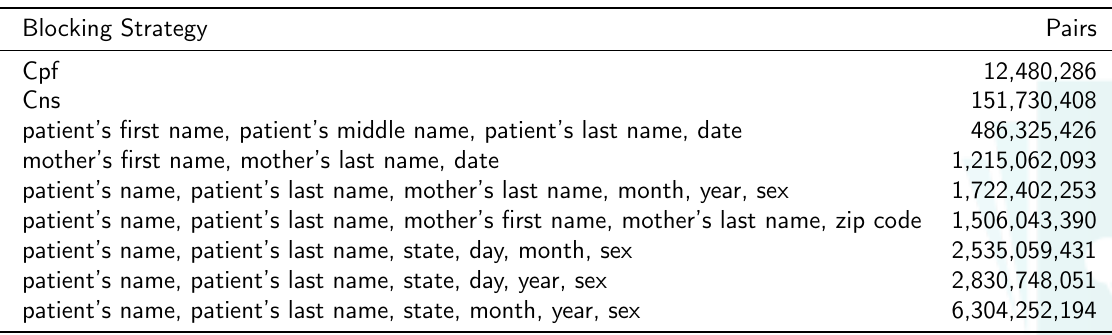
Table 3: Blocking strategy numbers of pairs